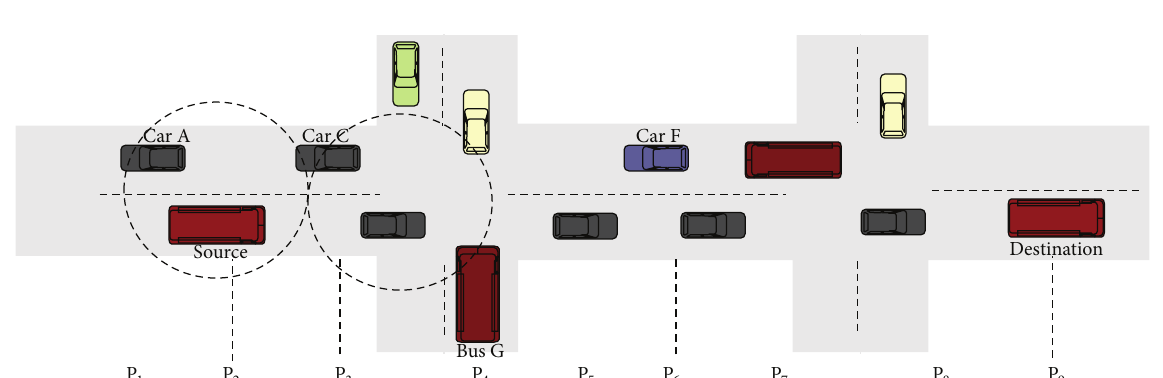
Figure 2: An example illustrating routing for time t 1 when network is fully connected.